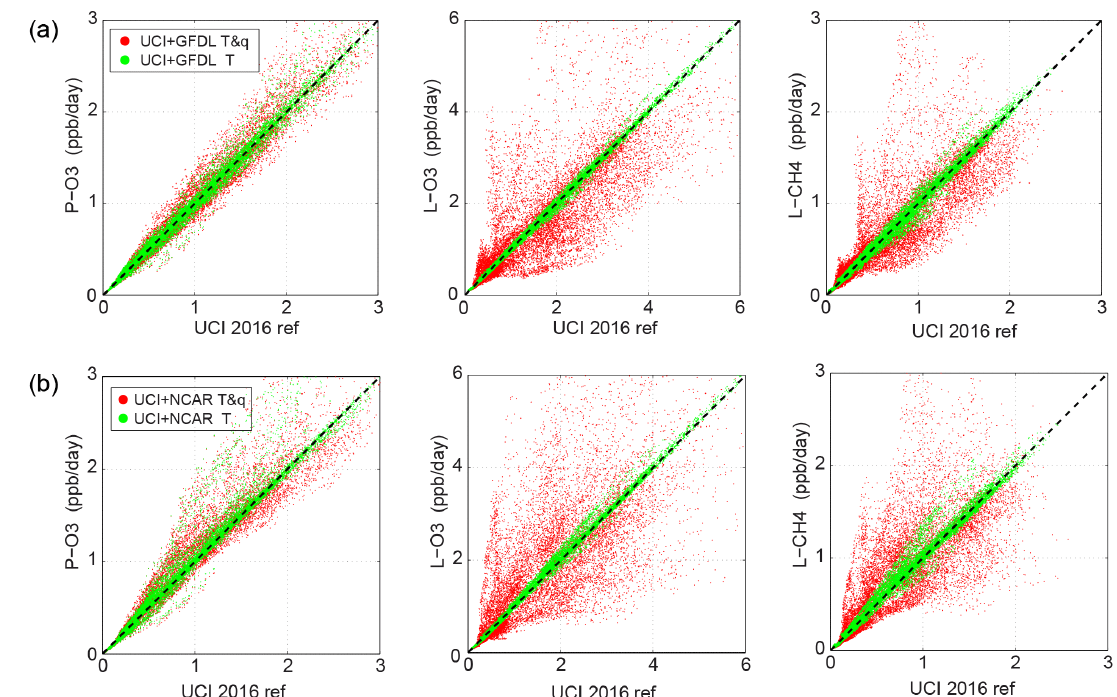
Figure 9. Scatter plot of reactivities of the 14880 air parcels showing the effect of the GFDL (a) and NCAR (b) models using T and q from their climate models, instead of from the specified data stream. The UCI model for a single day (16 August 2016) calculated reactivities using the GFDL and NCAR parcel values for T alone (green) and for T and q (red) and compared with the UCI reference model for 16 August